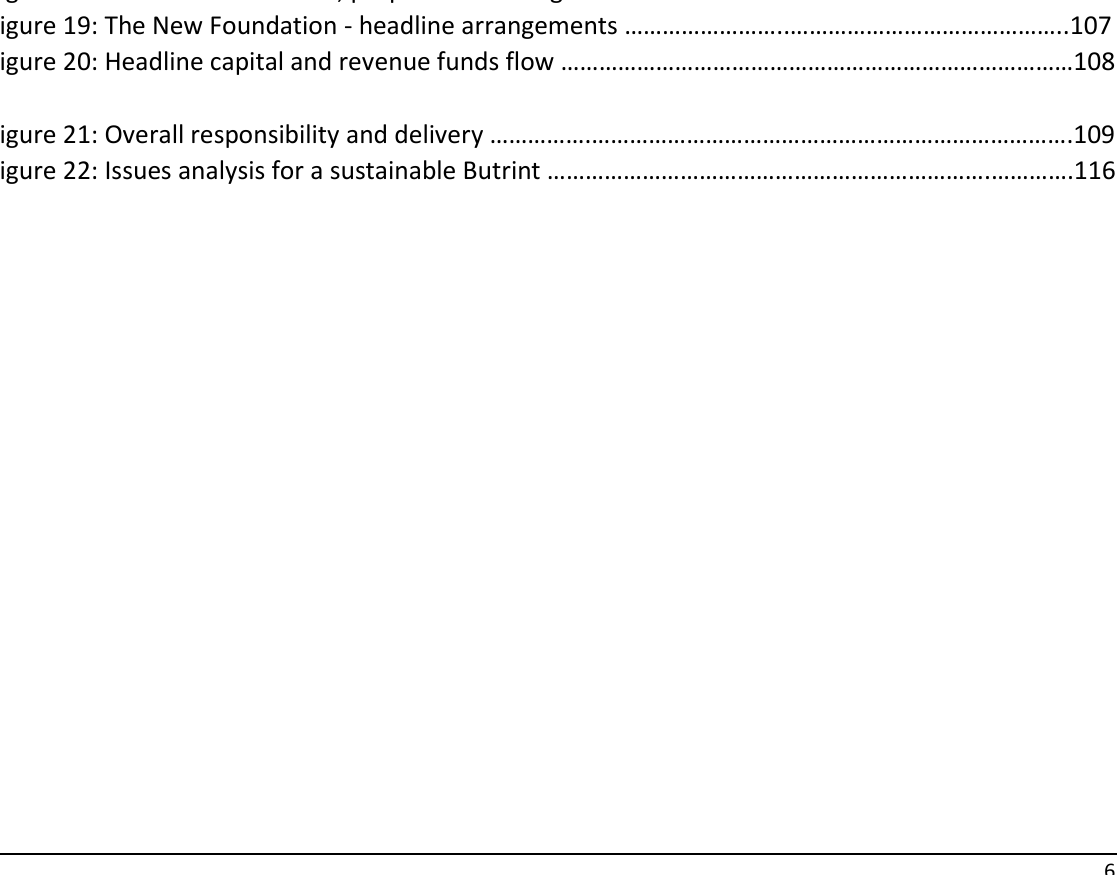
Figure 1: The map shows the current status of the protected areas in and around the World Heritage Site with regard to (a) the National Park (green), (b) the World Heritage Site (brown) and (c) its component A3 Zone (hatched green) ..................................................................................................... 8 Figure 2: The focus of the Integrated Management Plan in the Tor . ……………………………… .. ……….…….13 Figure 3: Current protected area designation ……………………………… . ………………………………….… .. ………..17 Figure 4: Possible expansion of the WHS to cover the whole of Lake Butrint ……… . …………… .. ………….31 Figure 5: Surface landscape characteristics …………………………………………………………………………..…………35 Figure 6: Existing National Park Zones .................................................................................................. 36 Figure 7: Existing National Park Sub-Zones ........................................................................................... 37 Figure 8: Growth in annual visitor numbers and peak months ............................................................ 74 Figure 9: Projected growth in visitor numbers 2018-2025 ................................................................... 75 Figure 10: Schematic of the main sites addressed within this Integrated Management Plan ............. 76 Figure 11: Primary places mentioned in the text …………………………………………………………………………….. 78 Figure 12: Proposed phases for the visitor centre (Phase 1=green; Phase 2=pink) ……….…………………6 8 Figure 13: Wider site opportunities and transport links ……………………………..………………….………………. 70 Figure 14: Possible walking trails. …..………………………………………………………………………….……………………. 74 Figure 15: One unifying management structure? ................................................................................96 Figure 16: Initial proposals for the new National Park Authority …………………………………………………..…9 7 Figure 17: Headline comparator analysis of management structures ……………………………………..……. 106 Figure 18: The New Foundation, proposed founding members ………………………………………………..…..1 07 Figure 19: The New Foundation - headline arrangements ……………………..……………………………………..10 7 Figure 20: Headline capital and revenue funds flow ………………………………………………………………………10 8 Figure 21: Overall responsibility and delivery …………….………………………………………………………………… .109 Figure 22: Issues analysis for a sustainable Butrint …………………………………………………………… . ………….1